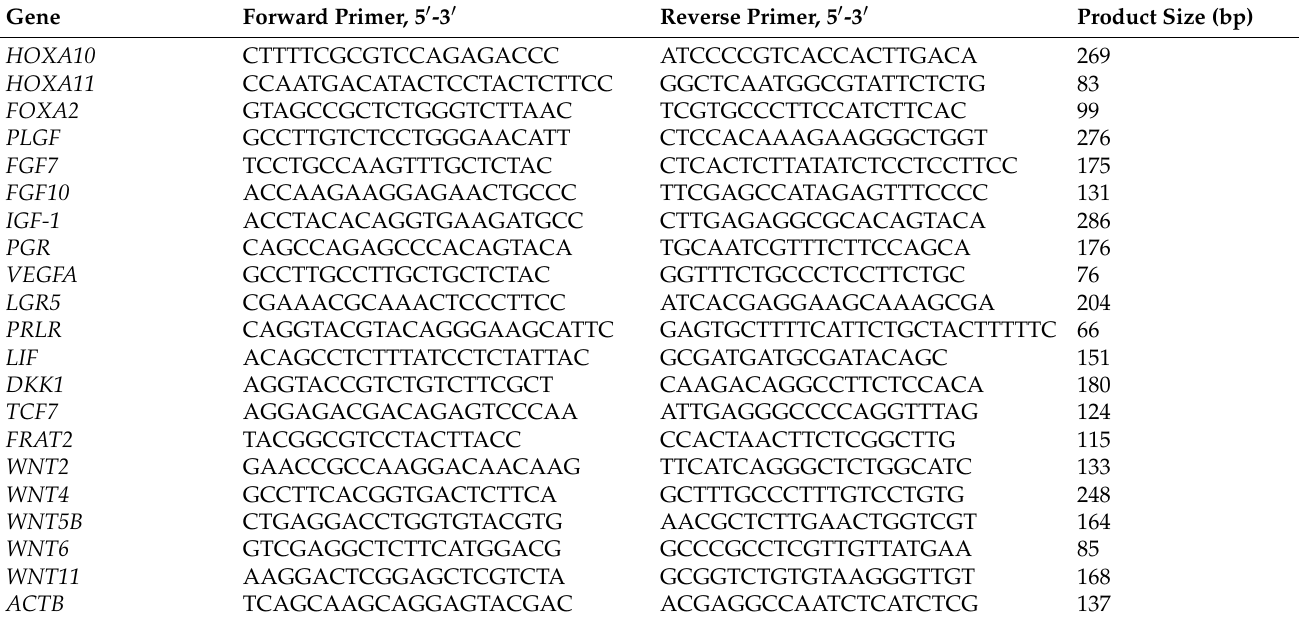
Table 2. Primers and sizes of the amplification products of tested